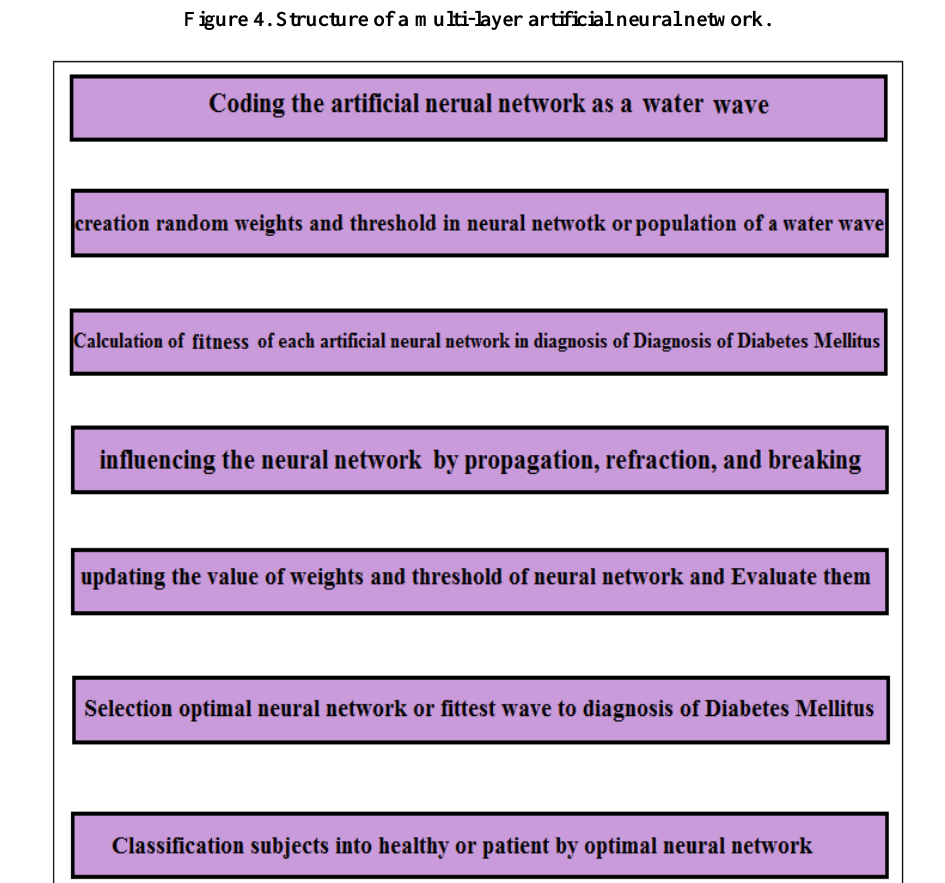
Figure 5. The flowchart proposed for the diagnosis of